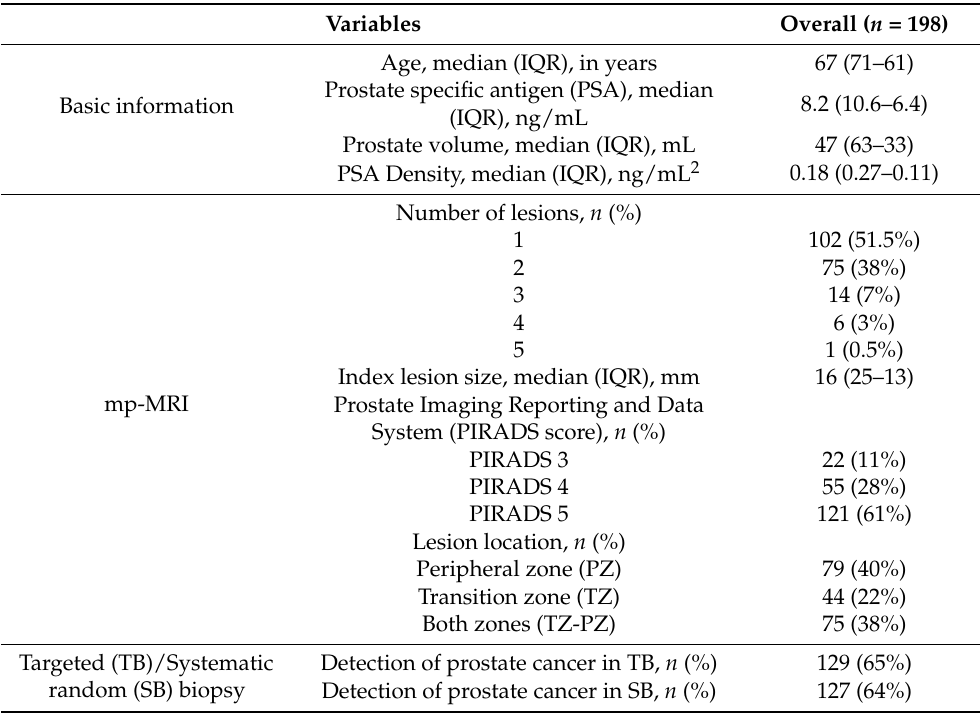
Table 1. Characteristics of participating